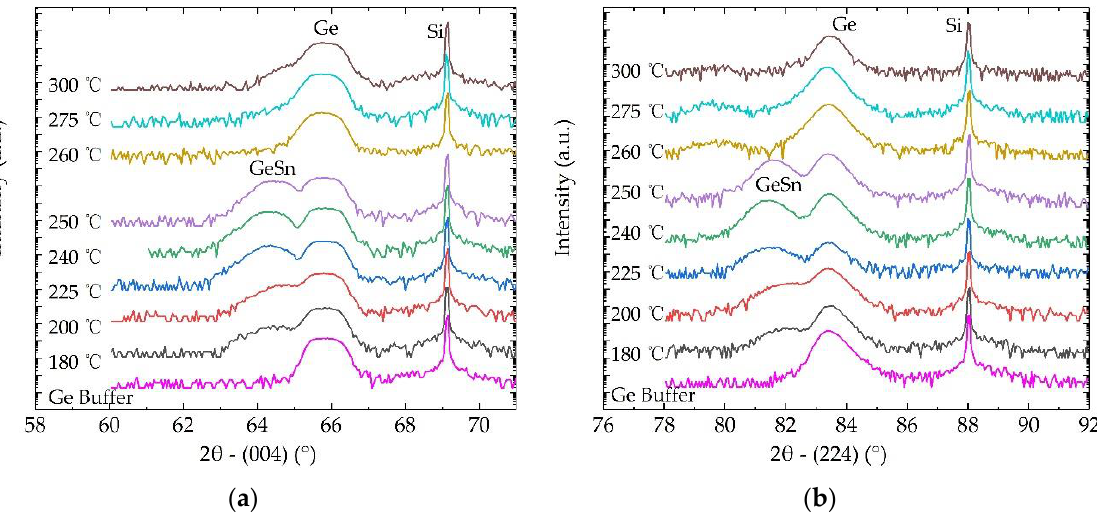
Figure 2. HR- XRD 2θ - ω scans of the Ge 1-x Sn x films on Si (100) for different deposited temperatures: Figure 2. HR-XRD 2 θ - ω scans of the Ge 1 − x Sn x films on Si (100) for different deposited temperatures: ( a ) (004); ( b ) (224). ( a ) (004); ( b ) (224).